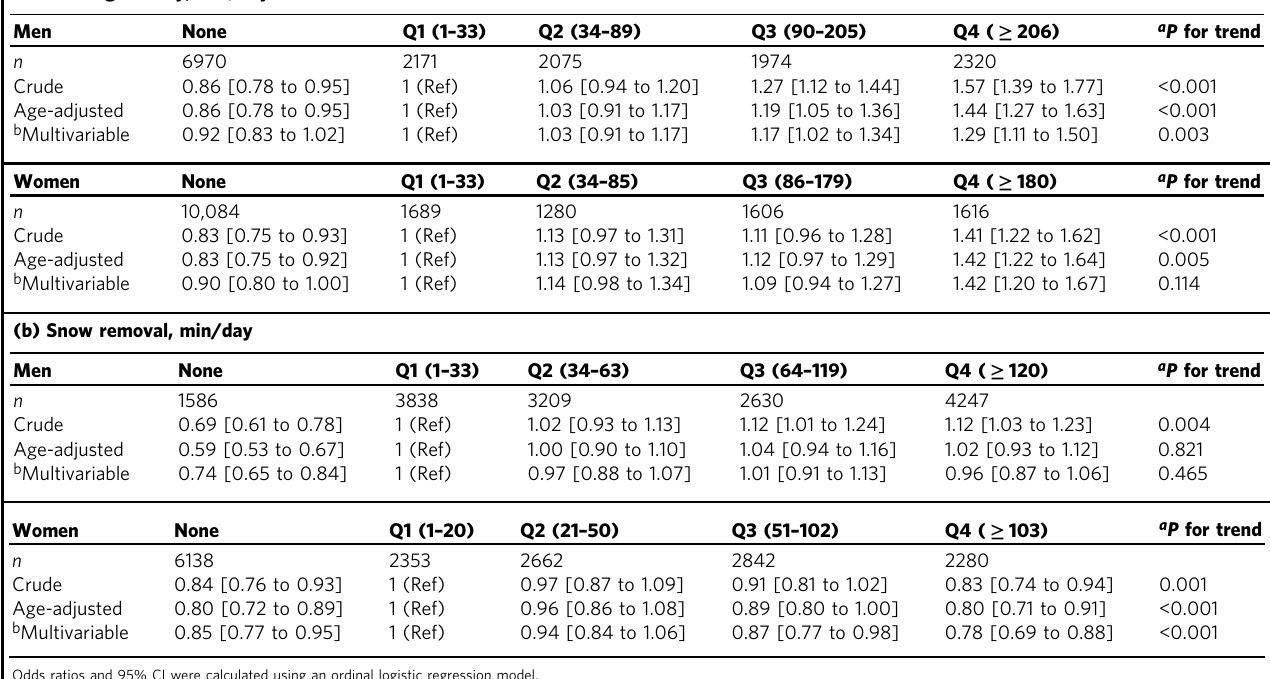
Table 3 Odds ratios (95% CI) of ikigai according to farming activity (a) and snow removal (b), by sex. (a) Farming activity,